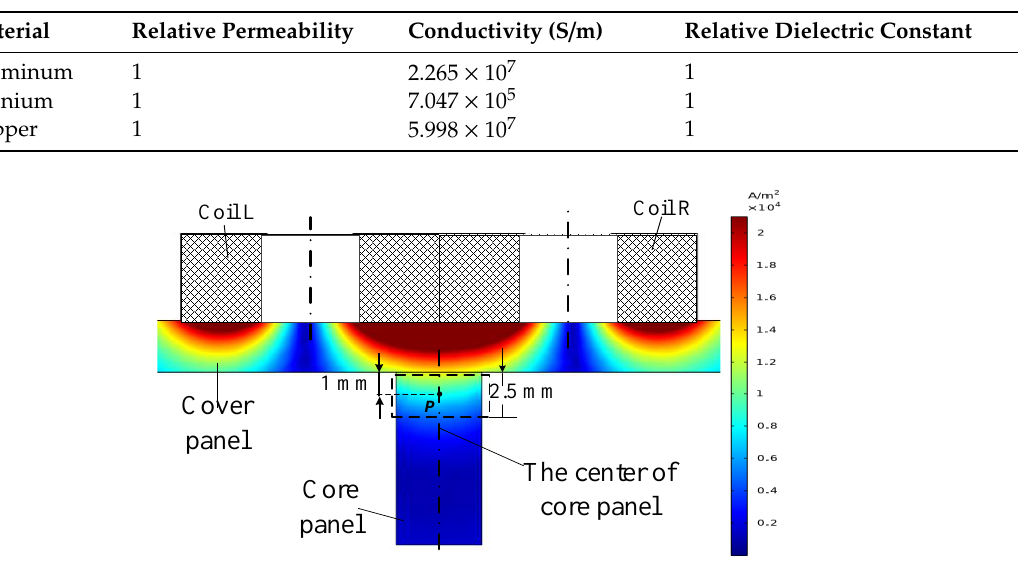
Figure 6. Distribution of the eddy current density in the specimen with excitation frequency f = 32.5 kHz.